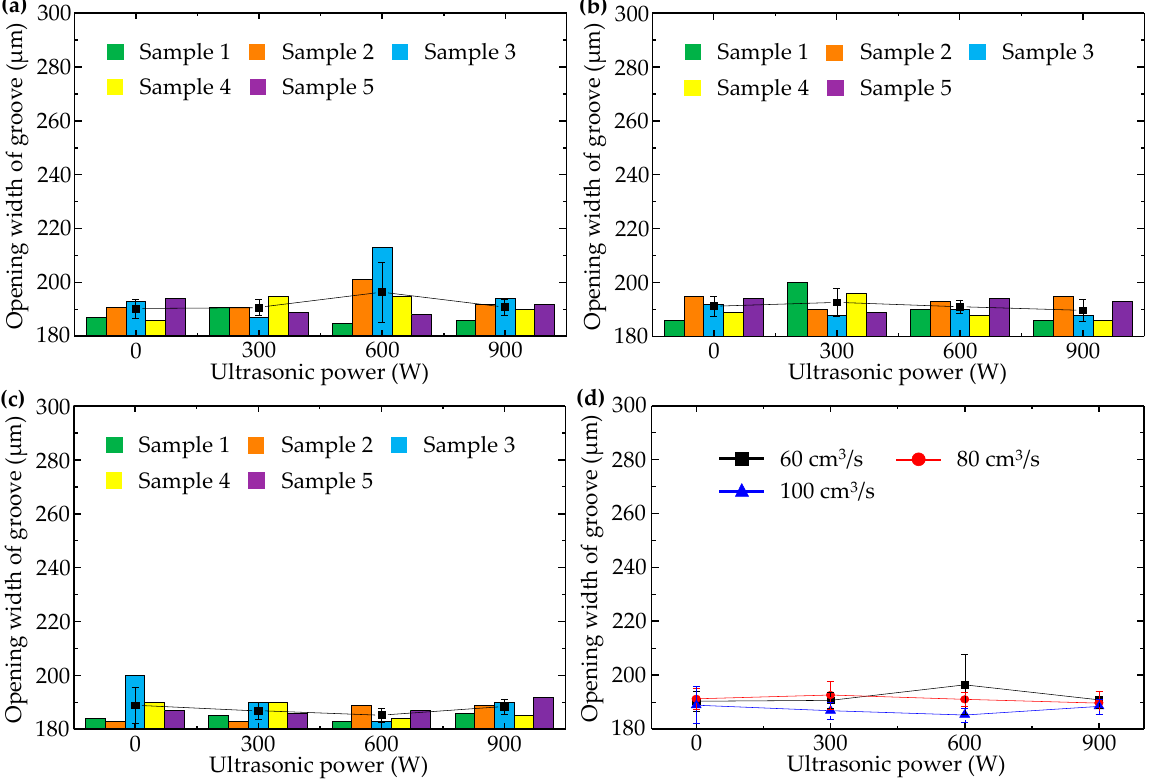
Figure 10. Variation of opening width of the transverse micro groove with ultrasonic power when injection pressure was 90 MPa and injection speeds were ( a ) 60 cm 3 /s, ( b ) 80 cm 3 /s, and ( c ) 100 cm 3 /s. ( d ) Comparison of the average values of each group.